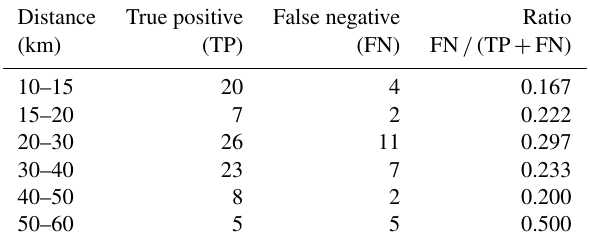
Table 4. Ratio FN / (TP + FN) considering the lower-limit rainfall threshold for different buffer distances to the rain